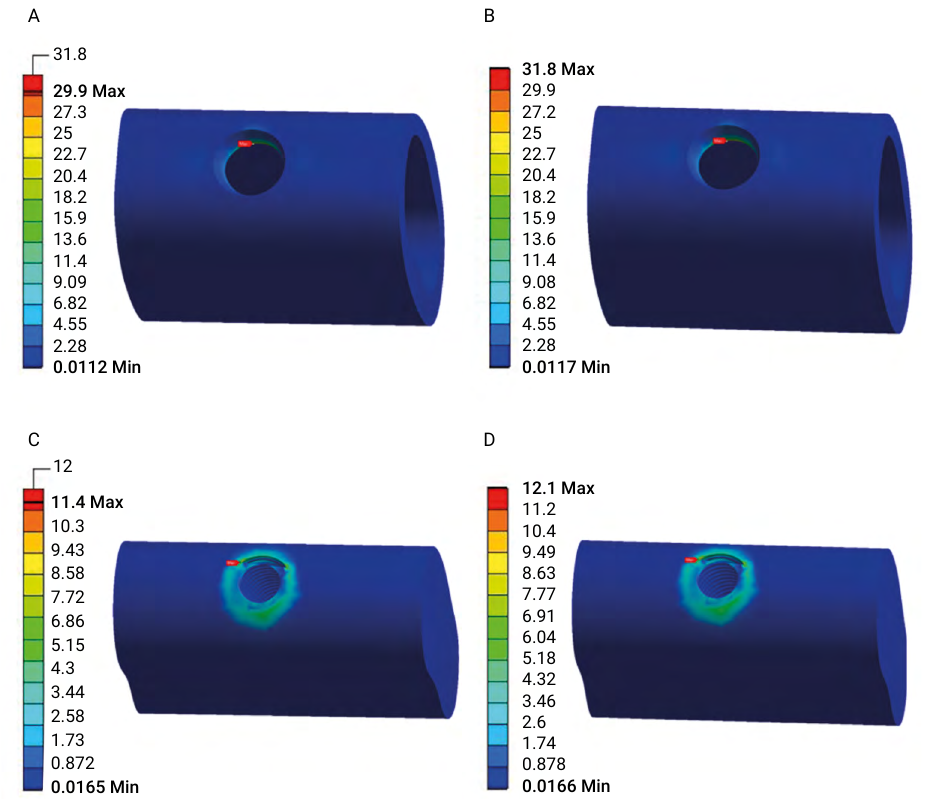
Figure 5. Stress distribution in the cortical and cancellous bone (τ ). Exterior view of the cortical bone of max the model restored with a 65 µm (A) and 38 µm (B) cement layer showing τ in the cervical inferior area max at the buccal portion. Exterior view of the cancellous bone of the model restored with a 65 µm (C) and 38 µm (D) cement layer showing τ at buccal max